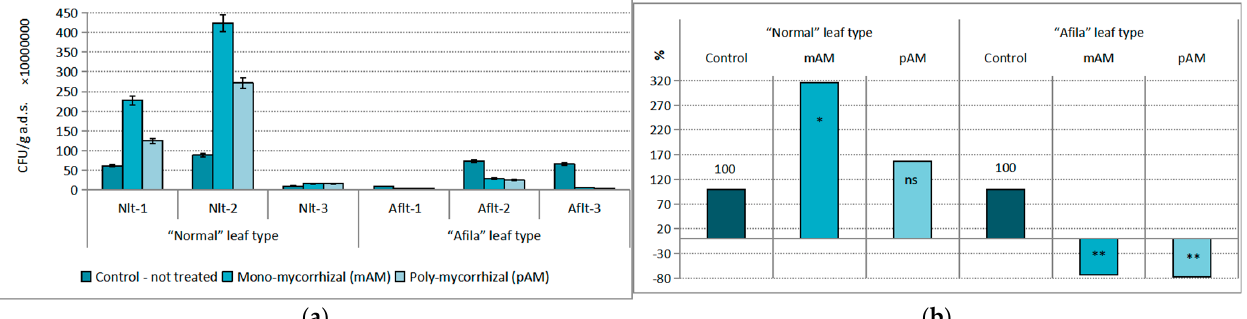
Figure 4. Average population density of the trophic group Immobilizing mineral ammonium ni- trogen (NH 4+ -N) bacteria (CFU ∙ g − 1 absolutely dry soil) in the rhizosphere communities formed